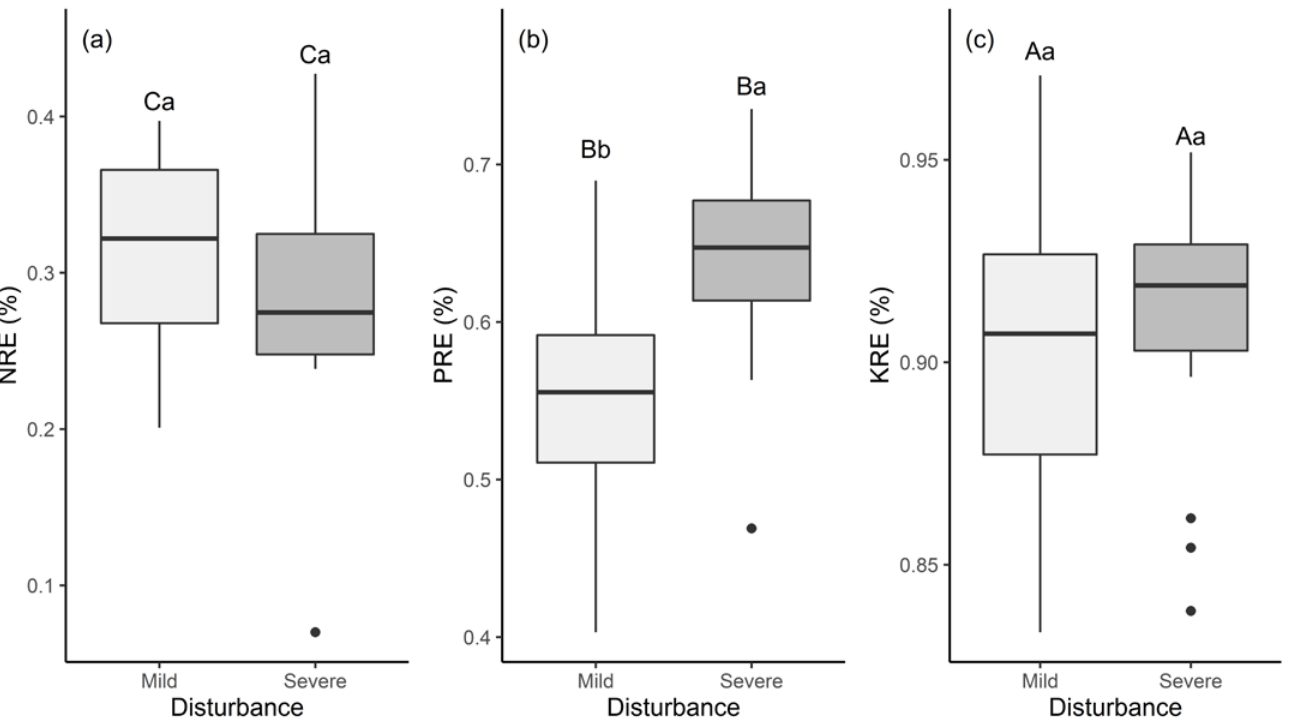
Figure 1. The nitrogen resorption efficiencies (NRE), phosphorus resorption efficiencies (PRE), and potassium resorption efficiencies (KRE) under the mild and severe disturbances ( a – c ) in the Phoebe bournei forest. The boxes represent the middle 50% of the data. The median line in the boxplot represents the median. Dots represent outliers. Different capital letters represent different nutrient resorption efficiencies under each disturbance. Different small letters represent significant nutrient resorption efficiencies under different disturbances.